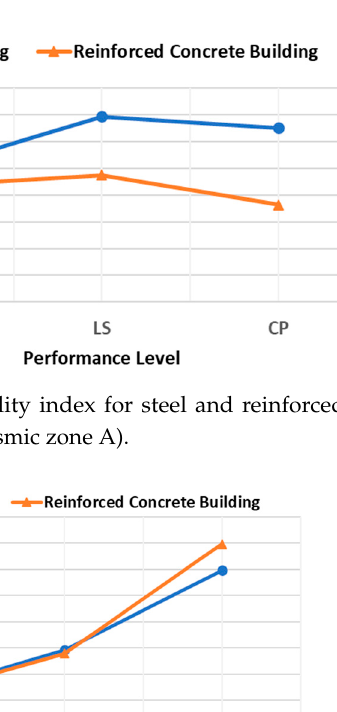
Figure 12. Mean reliability index for steel and reinforced concrete buildings located at Agua Prieta, Sonora (seismic zone C).